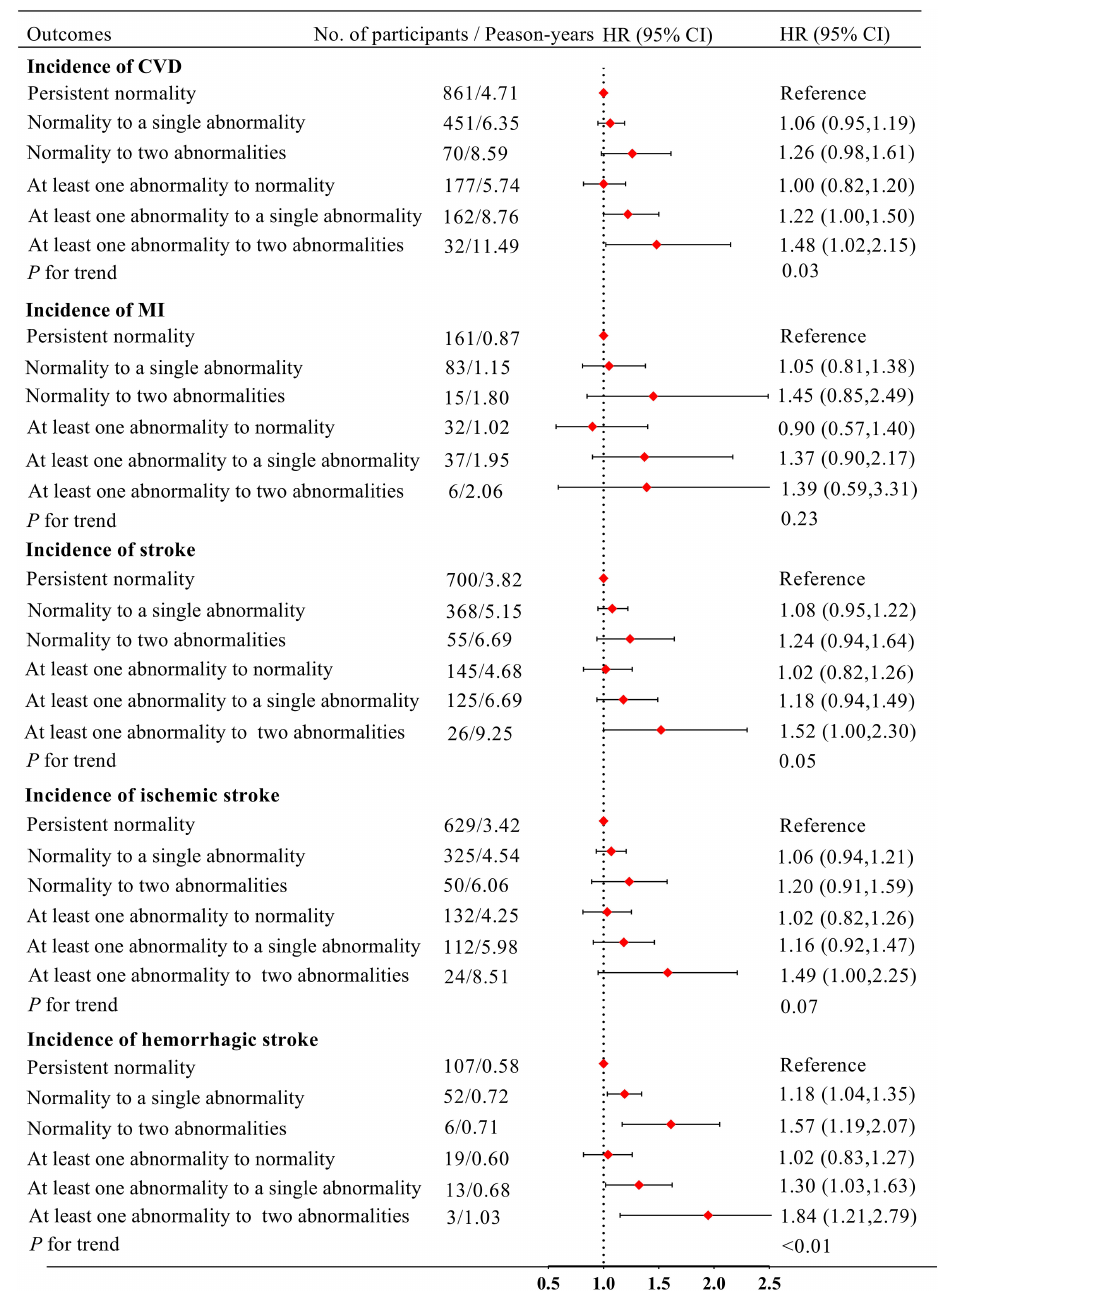
FIGURE 2 | Model adjusted for age, sex, obesity, smoking status, drinking status, physical exercise status, educational level, hypertension, use of anti-hypertensive drugs, HDL-C in 2010 and FBG, LDL-C in 2006. IFG, impaired fasting glucose; FBG, fasting blood glucose; HDL-C, high-density lipoprotein-cholesterol; LDL-C, low-density lipoprotein-cholesterol; CVD, cardiovascular disease; HR, hazard ratio; CI, confidence